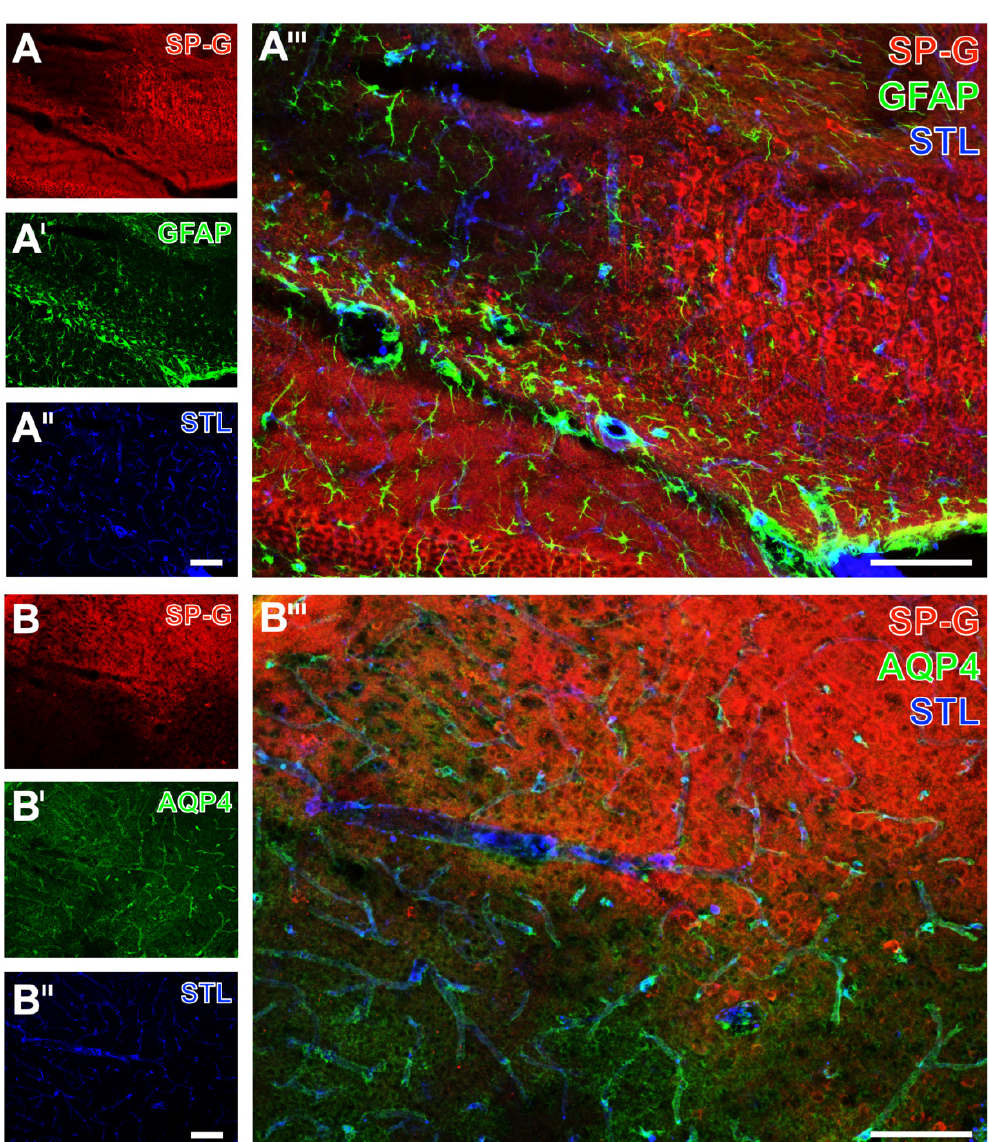
Figure 8. Astroglia, surfactant protein-G (SP-G), and vessels after focal cerebral ischemia in mice. Exemplary triple fluorescence labeling of SP-G, glial fibrillary acidic protein (GFAP), and lectin-based visualization (STL) of the vasculature in a mouse 24 h after focal cerebral ischemia in the affected hippocampus ( A – A’’’ ) and neocortex ( B – B’’’ ). Scale bars: A’’ (also valid for A and A’ ) = 100 μ m, A’’’ = 100 μ m, B’’ (also valid for B and B’ ) = 100 μ m, B’’’ = 100 μ m. Overall, the applied multiple fluorescence labeling in mice revealed several regional associations between SP-G and elements of the ischemia-affected NVU. In detail, decreasing immunosignals of neurons came along with a decreased signal of SP-G and an increased signal of collagen IV. Despite the strong regional association of changed SP-G-ir and vascular elements, a definite co-localization was not seen. Concerning glial elements, the ischemia-associated reduction of the SP-G signal co-occurred with an increased signal of oligodendroglial CNP and morphological changes of micro- and astroglia.